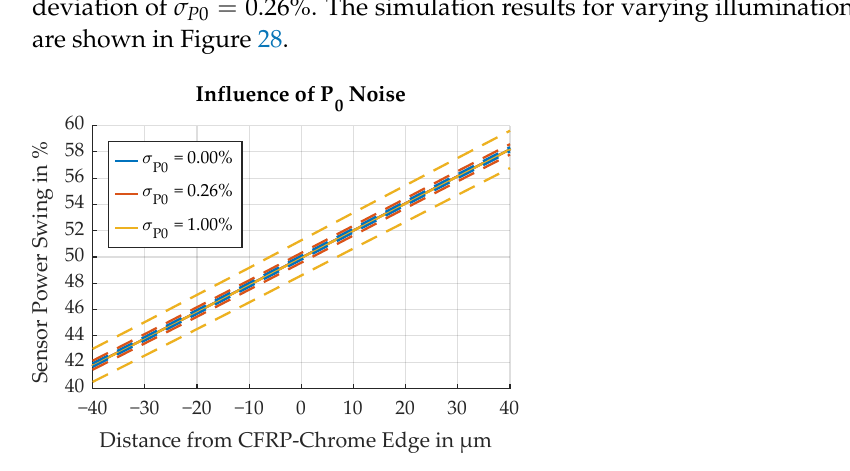
Figure 28. Influence of noise in the illumination source power P 0 on the threshold position ∆ thresh . Dotted lines represent ± σ .